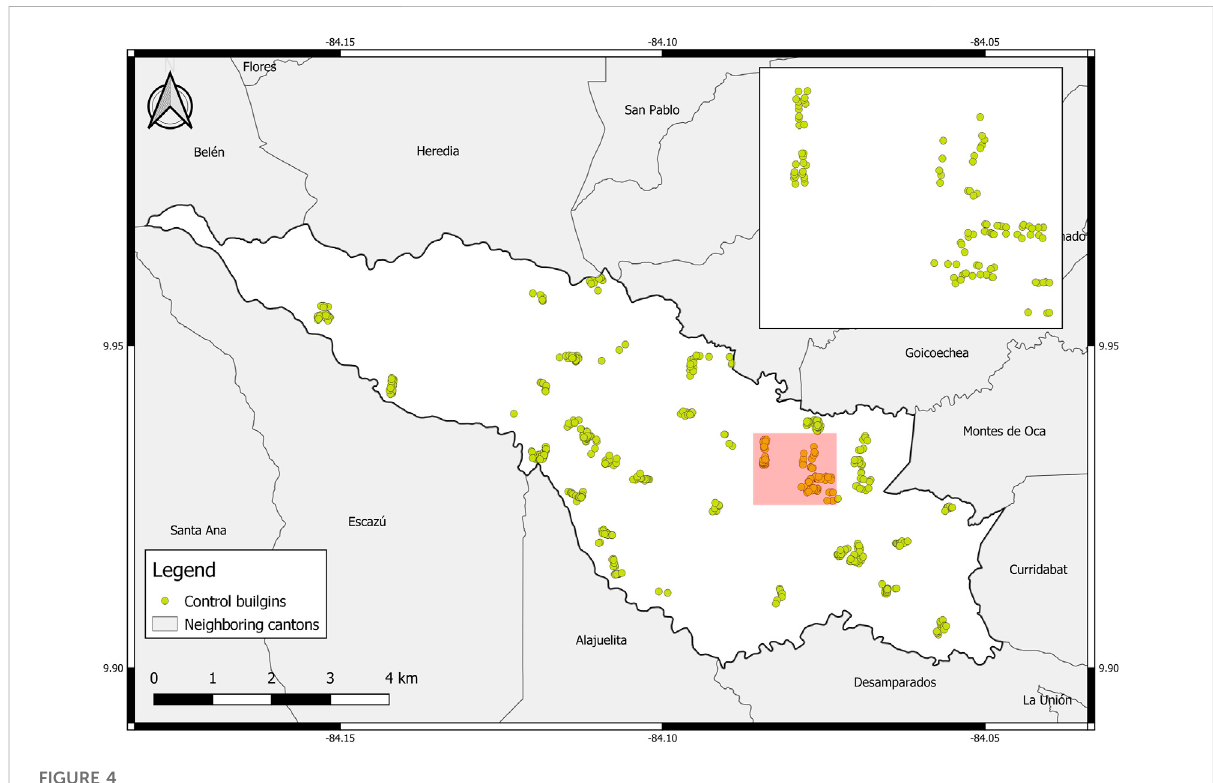
FIGURE 4 Location of the control buildings in the San José